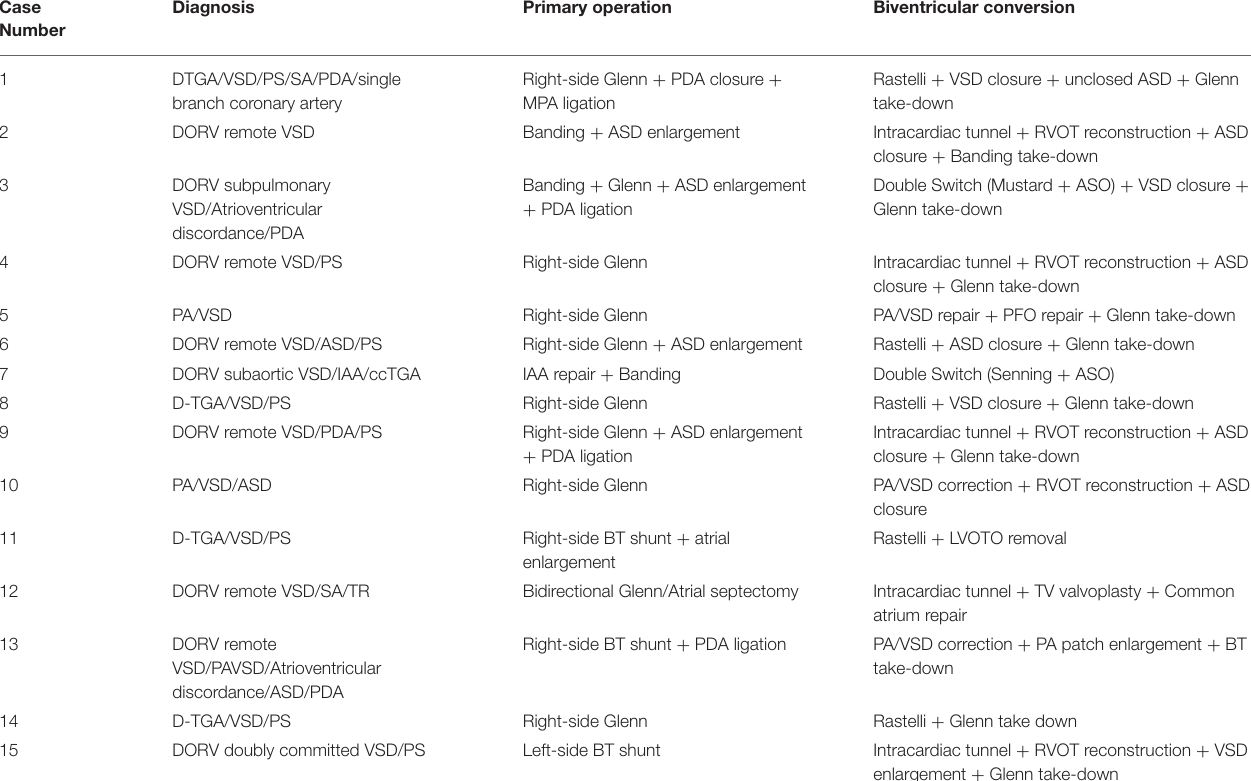
TABLE 3 | Operative data of each case receiving biventricular conversion in the balanced ventricular group. Case Number